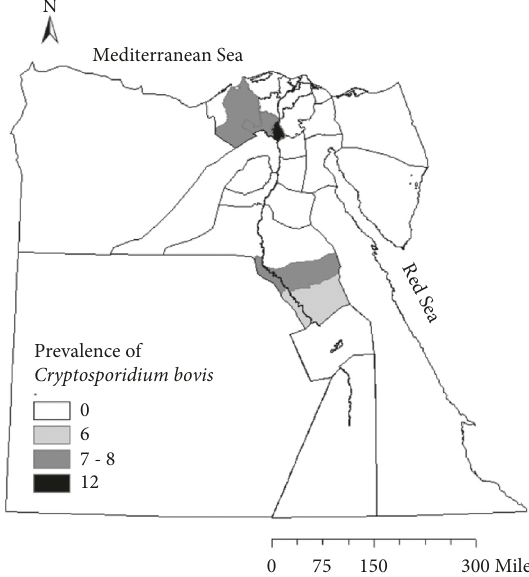
Figure 1: Cryptosporidium bovis among different governorates in